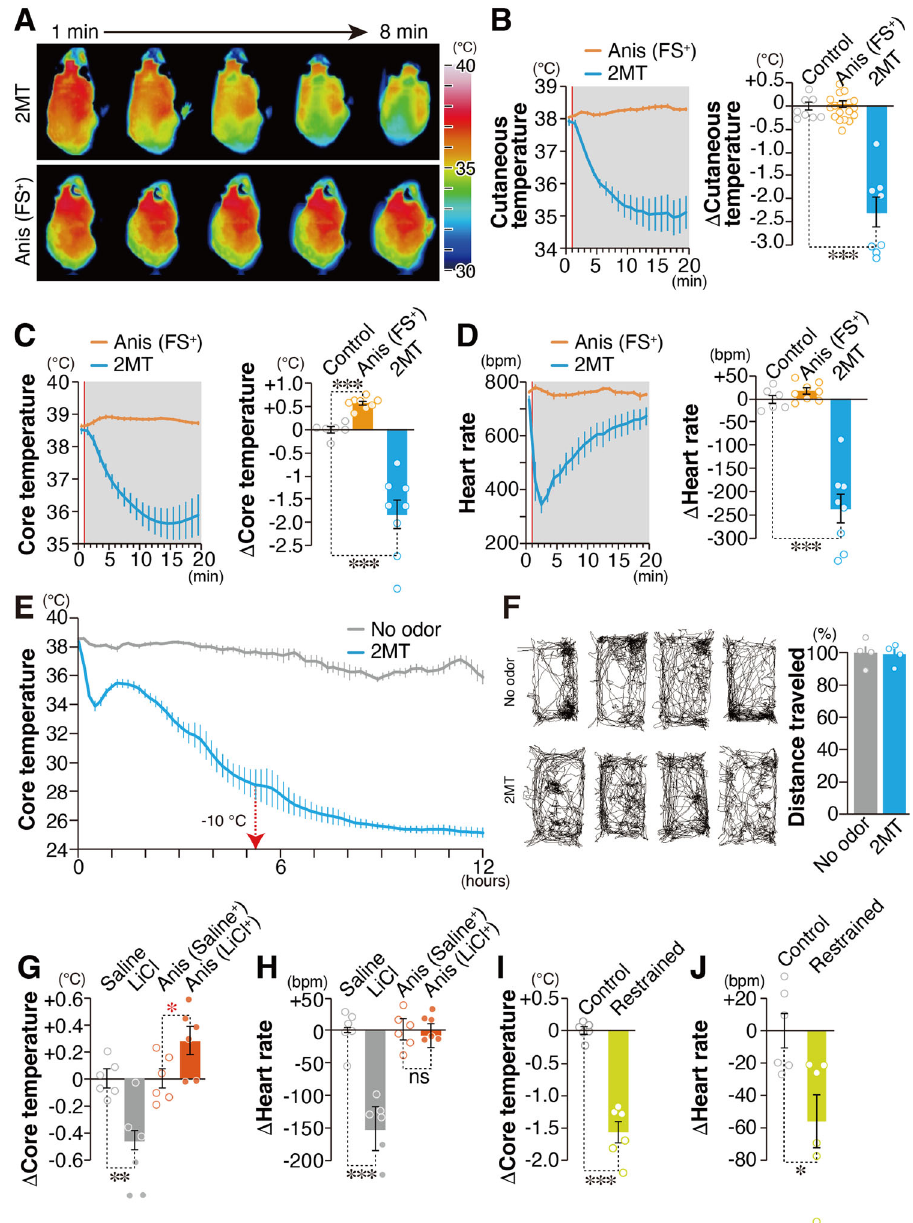
Fig. 1 Physiological responses induced by innate versus learned fear stimuli. A Infrared dorsal view images taken 1 – 8 min after odorant presentation. B – D Temporal analyses (left panels) and the mean values (right panels) for cutaneous temperatures ( B ; n = 8 for control, n = 18 for Anis (FS + ), and n = 8 for 2MT), core body temperatures [ C ; n = 6 for control, n = 8 for Anis (FS + ), and n = 8 for 2MT], and heart rates ( D ; n = 6 for control, n = 8 for Anis (FS + ), and n = 8 for 2MT) in response to a conditioned odor (anisole) paired with foot shock [Anis (FS + ); orange] and 2MT (blue). Red vertical lines indicate the onset of odor presentation. E Temporal analyses of core body temperature in response to long exposure to 2MT and no-odor control ( n = 6 each). Filter paper scented with 2MT or saline was introduced into the test cage with a lid at 10 min. Core body temperature decreased by >10°C after 5 h of the odor presentation (red arrow) and reached near-ambient temperature (~2 °C above ambient temperature) after 12 h. Decreasing body temperature to 2 – 3 °C above ambient temperature is observed in torpor 26 . F Filter paper scented with 2MT or saline was introduced into the cage, which was then covered by a plastic wrap for 6 h. After 1 week of recovery, mice were transferred into a new cage and locomotor activities were analyzed ( n = 4 each). Track plots of the movement (left) and the mean distance traveled (right) are shown. G , H The mean change in core body temperature ( G ) and heart rate ( H ) in response to intraperitoneal (IP) injection of saline or LiCl (gray) and those induced by a conditioned odorant (anisole) paired with IP injection of saline or LiCl [Anis (Saline + ) or Anis (LiCl + ); orange ( n = 6 each)]. I , J The mean change in core body temperature ( I ) and heart rate ( J ) in response to 5 min of restraint (yellow) and control condition ( n = 6 each). Data are means± SEM. One-way ANOVA followed by Dunnett ’ s multiple comparison or Student ’ s t test was performed. * P < 0.05; *** p < 0.01; *** p < 0.001; n.s. not signi fi cant.